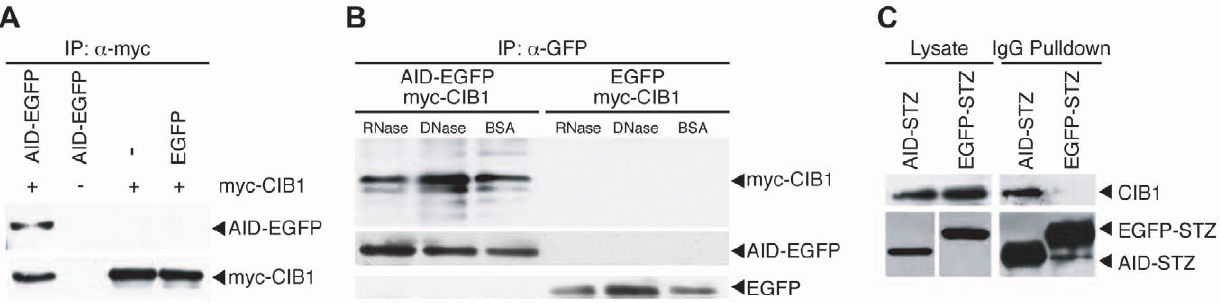
Figure 1. AID interacts with the calcium and integrin binding protein 1. A . myc-CIB1 co-IPs AID-EGFP but not EGFP only (left and right lanes, respectively). A myc-specific monoclonal antibody was used to precipitate complexes, and AID-GFP was detected with an a -GFP polyclonal antibody. B . AID-EGFP co-IPs myc-CIB1 in a DNase I- and RNase A-resistant manner. An a -GFP monoclonal antibody was used to precipitate AID-GFP, and myc- CIB1 was detected with an a -myc monoclonal antibody. C . AID-STZ pulls down endogenous CIB1 from HEK-293T cell extracts. IgG Sepharose was used to pull-down STZ complexes, and CIB1 was detected using an a -CIB1 polyclonal antibody. AID-STZ and GFP-STZ were detected with an a -strep antibody. A low level of non-specific background was observed in the vicinity of AID-STZ. For cell lysate (input) control blots, two panels are shown because GFP-STZ is expressed over 100-fold better than AID-STZ. A quantification of the input versus pull-down signal indicated that 1% of cellular CIB1 can be pulled-down with AID complexes when IgG sepharose beads are